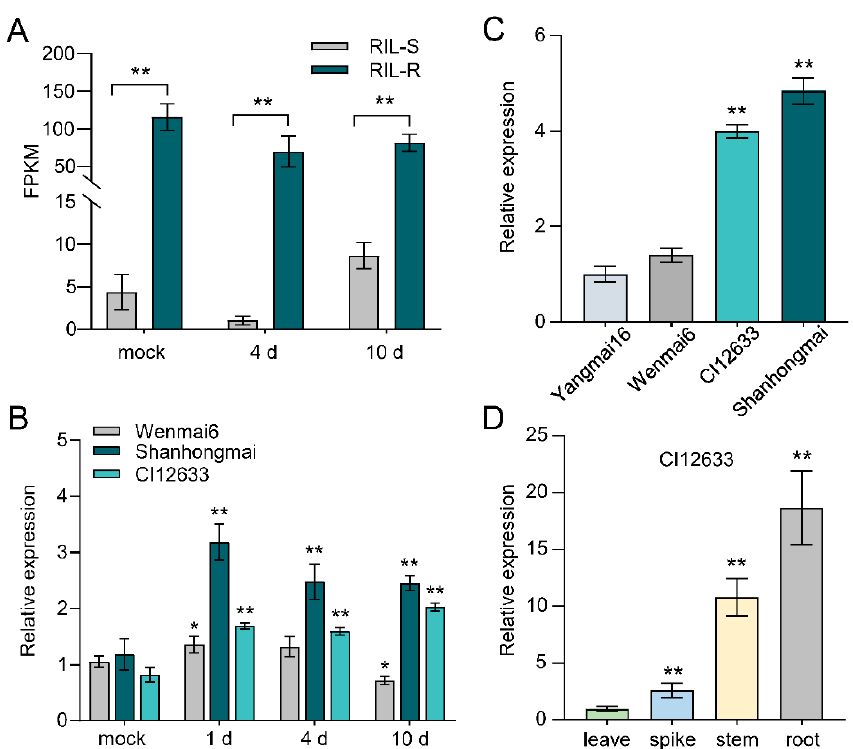
Figure 1. The expression profiles of TaPIMA1 in wheat with R. cerealis infection. ( A ) The expression pattern of TaPIMA1 in RNA-seq data of RILs. The sharp eyespot resistant/susceptible RILs were infected with R. cerealis and sampled at 4 and 10 dpi. ( B ) Transcript profiles of TaPIMA1 in sharp eyespot-resistant cultivar CI12633 and the susceptible wheat cultivar Wenmai6 at 1, 4, and 10 dpi with R. cerealis. ( C ) The expression patterns of TaPIMA1 in four wheat cultivars. All transcript data of TaPIMA1 were compared with those in Yangmai16. ( D ) Transcriptional analyzes of TaPIMA1 in different organs of CI12633 plants. The significant differences determined by one-way ANOVA (* p < 0.05, ** p < 0.01). Error bars indicates standard deviation.